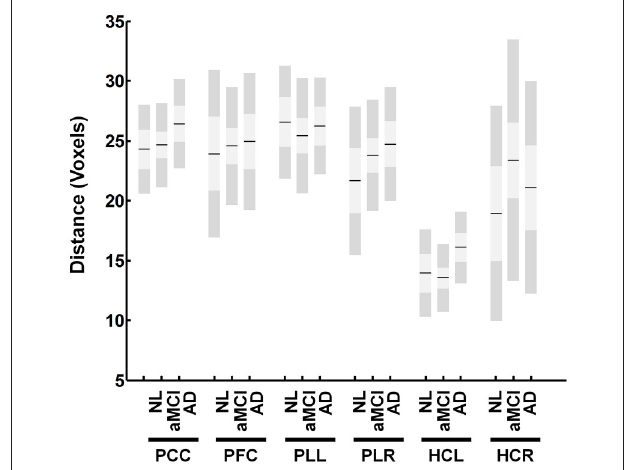
FIGURE 6 | Distance between identified nodes for the DMN. The figure shows the average distance in voxels between identified nodes within each region. The figure shows no significant differences between